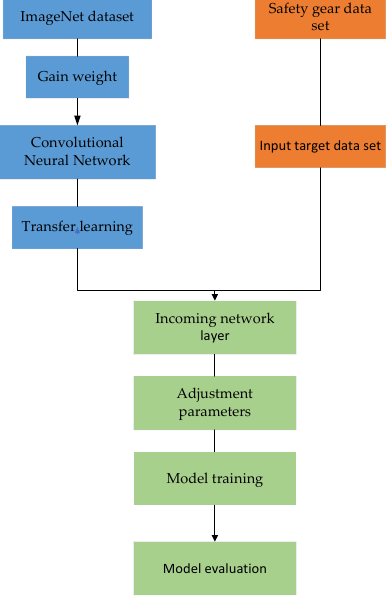
Figure 5. Transfer learning process. ResNet50, He et al. [21], is fine-tuned using transfer learning, where the ImageNet dataset and the ResNet50 network are initialized with the trained weight parameters. On this basis, the lifting operation driver behavior dataset is used to train and adjust the